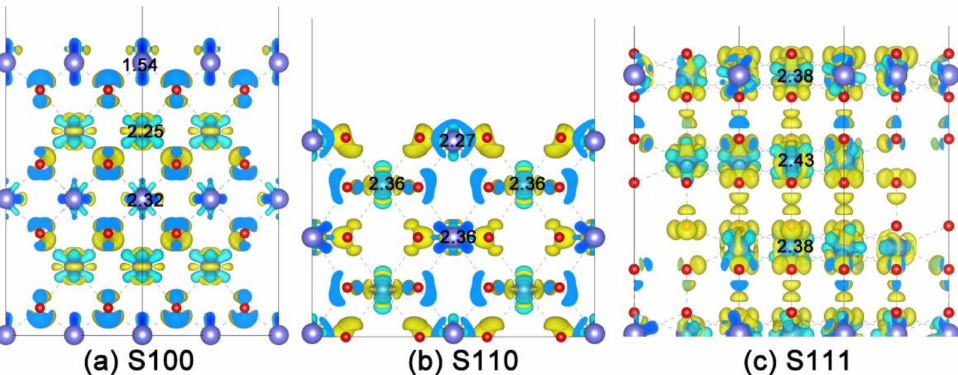
Figure 5. The 3D plots of charge density difference with an isosurface value of 0.02 e /Bohr 3 for pristine CeO 2 with different oriented surfaces: ( a ) for S100, ( b ) for S110 and ( c ) for